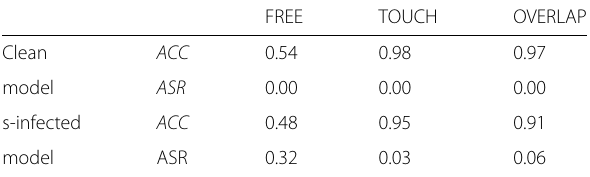
Table 5 Performance of the clean (top) and s -infected (bottom) models on the clean version of the OR dataset broken down by the degree of overlap FREE TOUCH OVERLAP